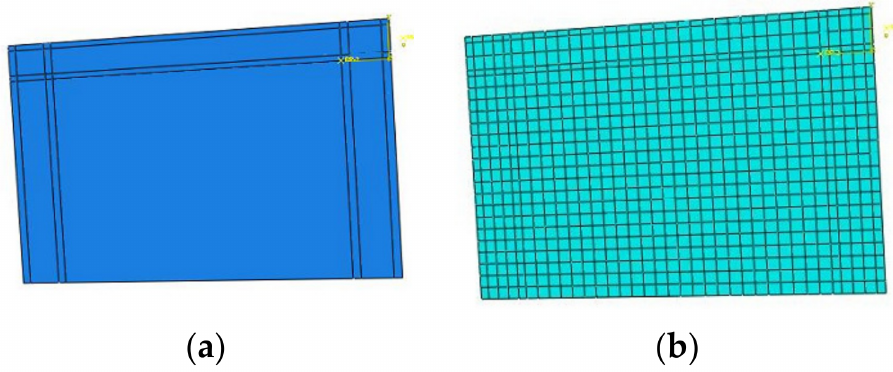
Figure 10. ( a ) Wall numerical model; ( b ) wall mesh.